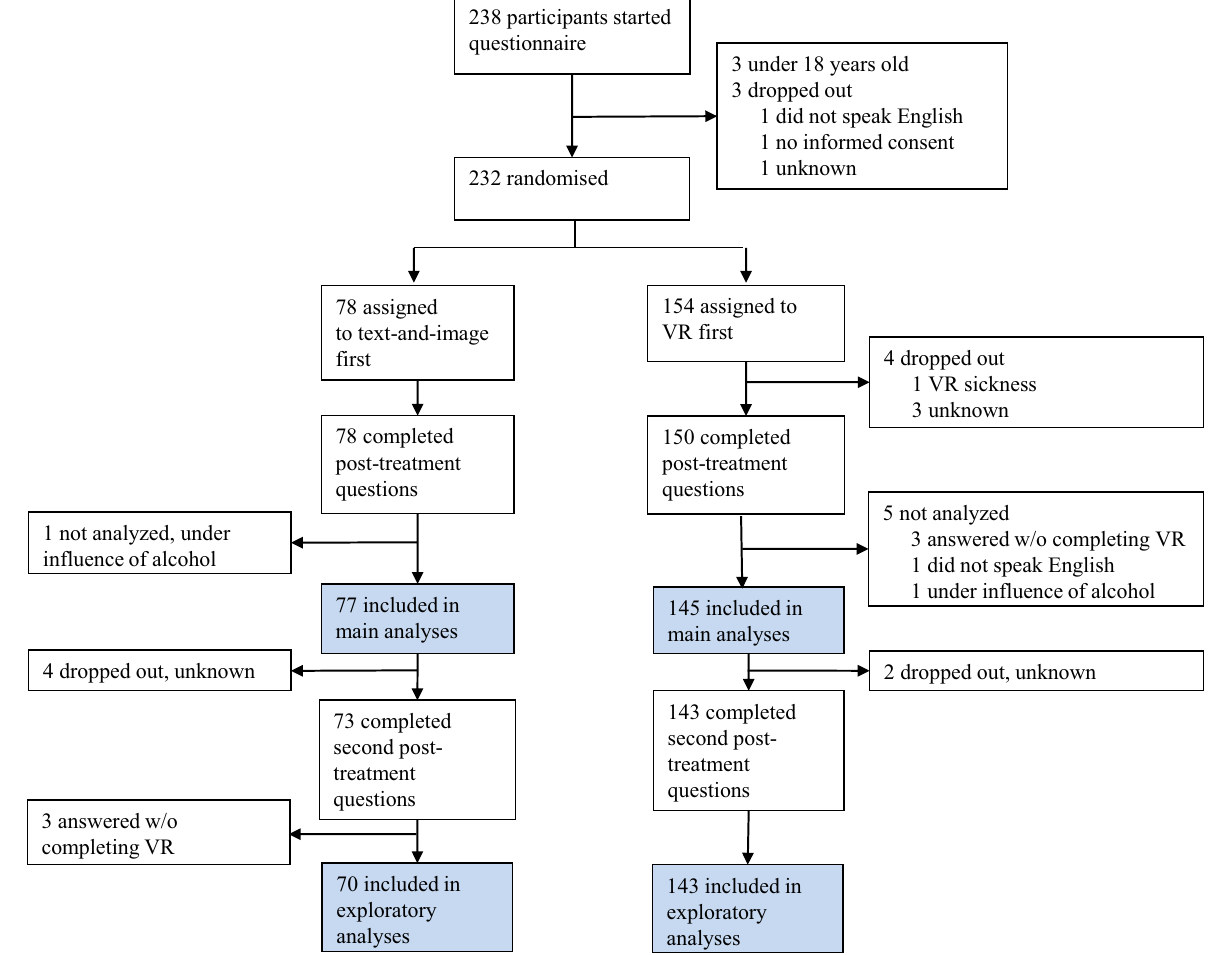
Figure 1. Trial profile showing flow of participants into treatment arms and analyses. Because participants largely self-administered the questionnaires and treatments, needing assistance only to start up the VR simulation, dropout reasons are sometimes